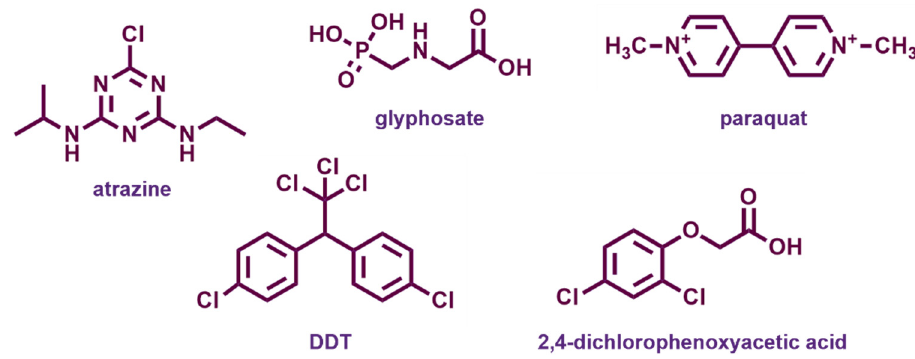
Figure 9. Chemical structures of the most widespread agrochemicals with endocrine disrupting properties.